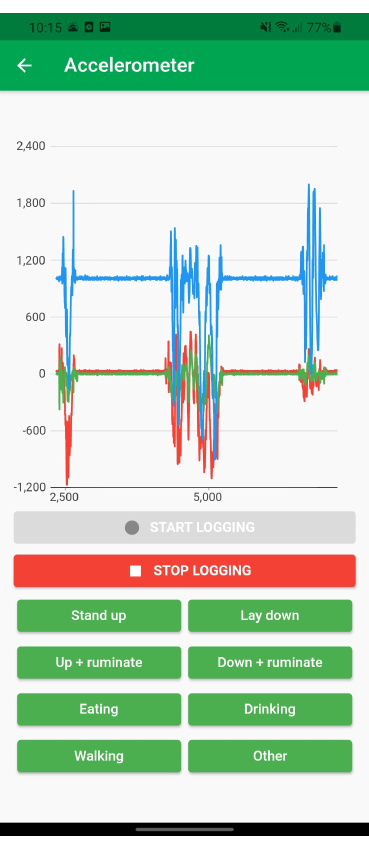
Figure 3. Mobile application for the data acquisition. The upper part shows the real-time 3-axis plot and the bottom part shows the buttons to be pressed by observers. The “start logging” and “stop logging” buttons can be pressed to start and stop the recording of data and the buttons with the behaviors (stand up, up + ruminate, eating, walking, lay down, down + ruminate, drinking, other) can be pressed to enter the behavior classification.